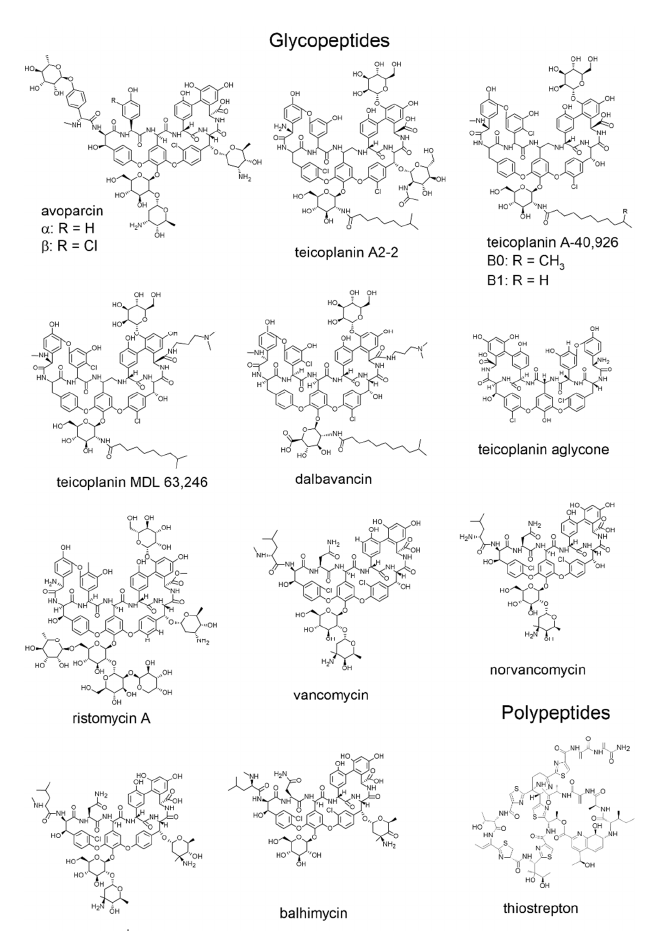
Figure 1. Structure of ansamycins.